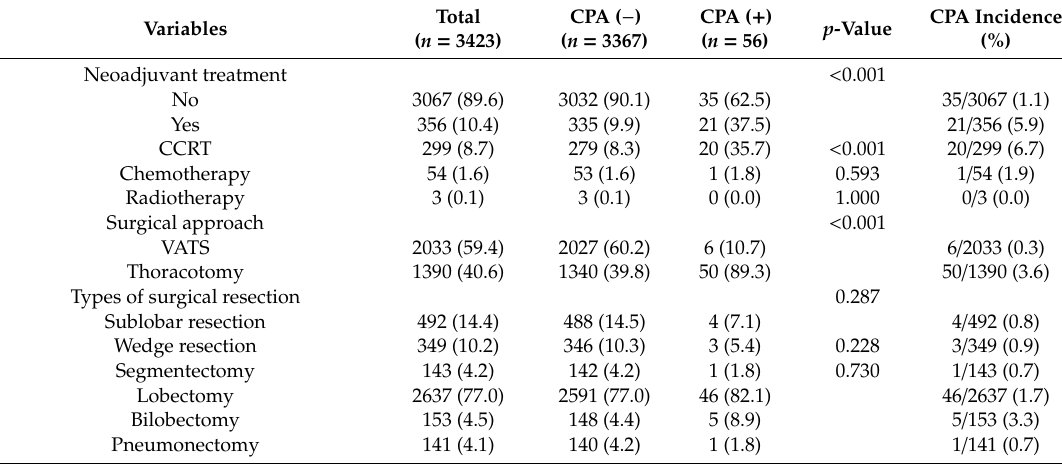
Table 2. Treatment profile for NSCLC and the development of chronic pulmonary aspergillosis after lung